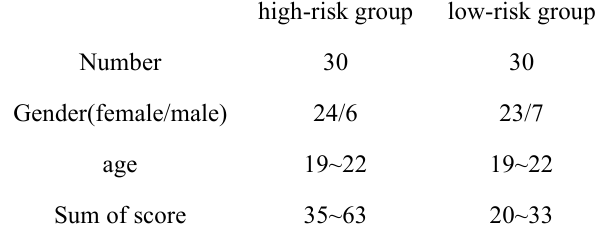
Figure 6. Flow chart of feature selection